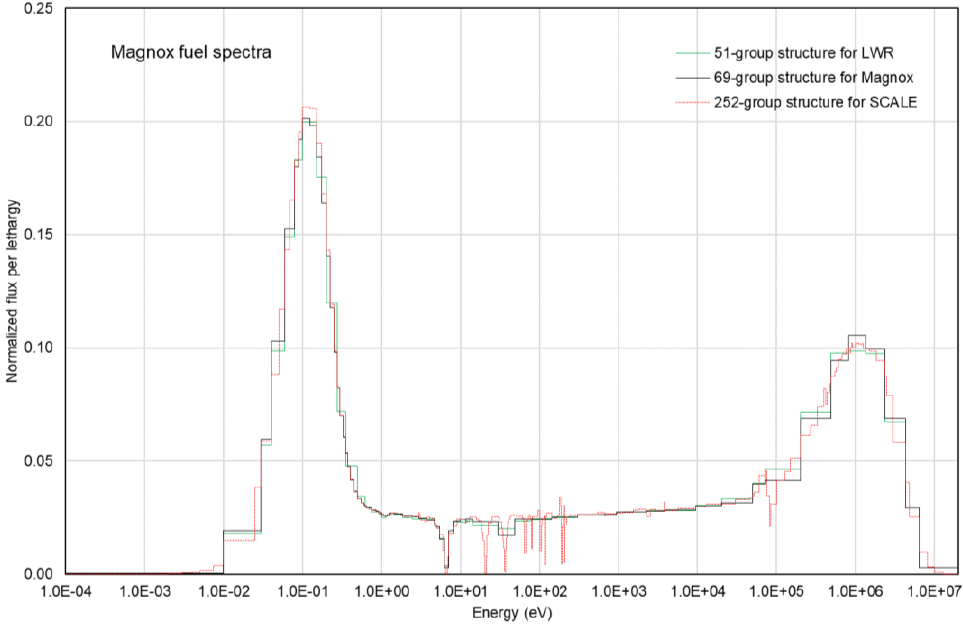
Figure 3. Comparison of energy group